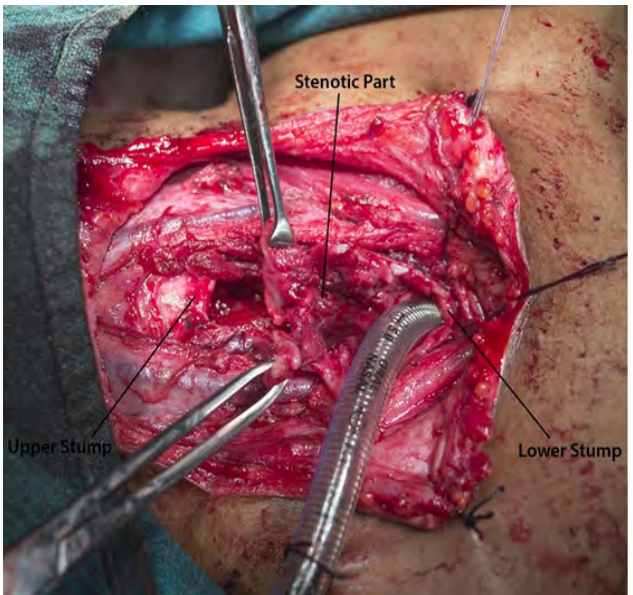
Fig 3 : Upper and lower tracheal stump and the stenotic portion